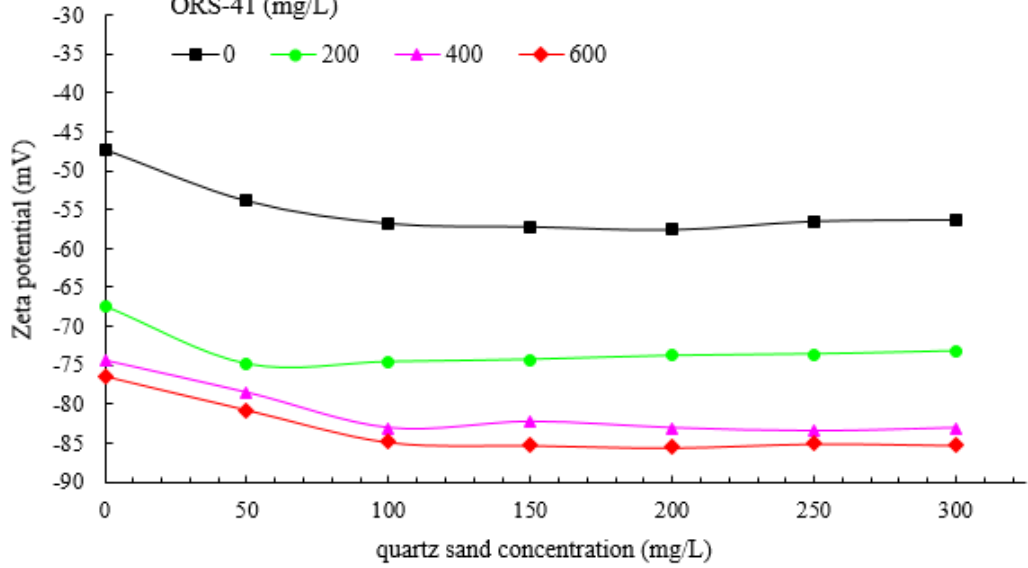
Figure 7. The synergetic effect of surfactant and quartz sand particles on Zeta potential (polymer concentration 500 mg/L, alkali concentration 600 mg/L).